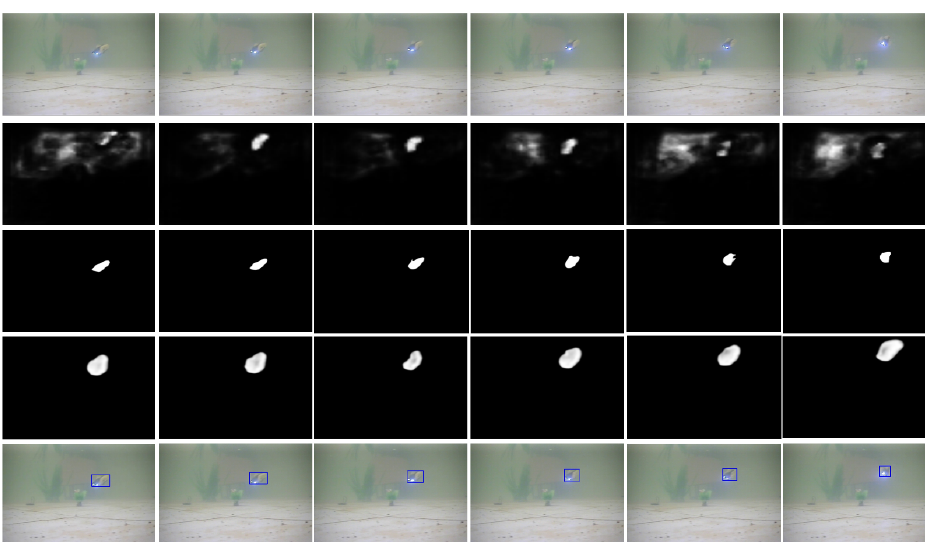
Figure 6. Results of Camera R saliency detection.